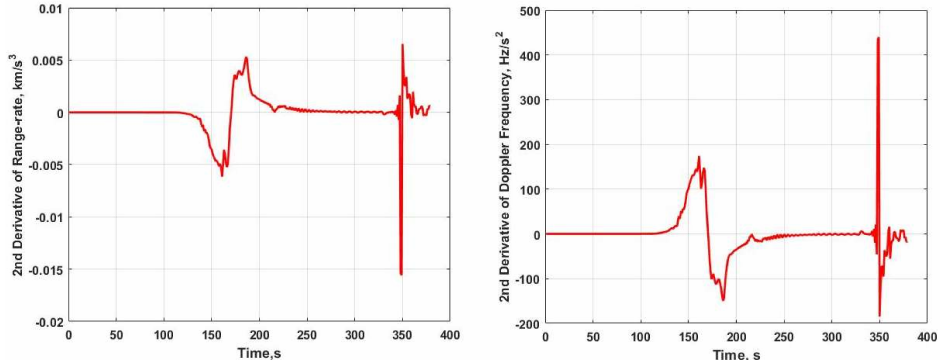
Figure 5. Computed second-order derivative values of Doppler for MSL: ( a ) Second-order derivatives of range-rate; ( b ) Second-order Doppler rate